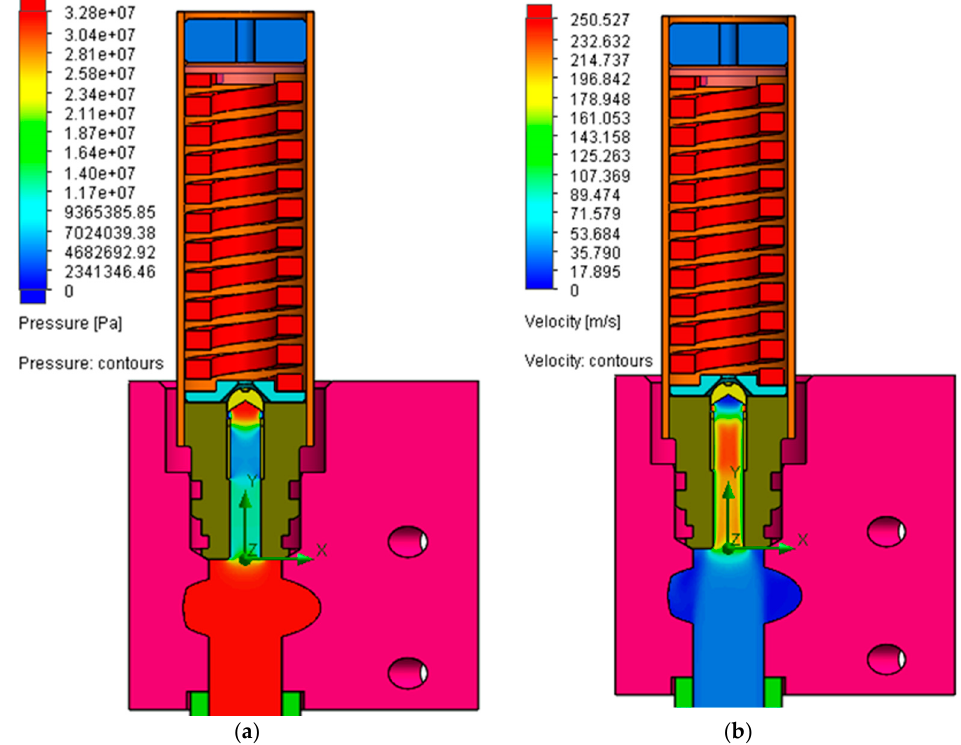
Figure 17. The variation maps of pressure ( p ) ( a ) and velocity ( υ ) ( b ) for a 0.007 m 3 ·s -1 volume flow rate (420 L·min -1 ).